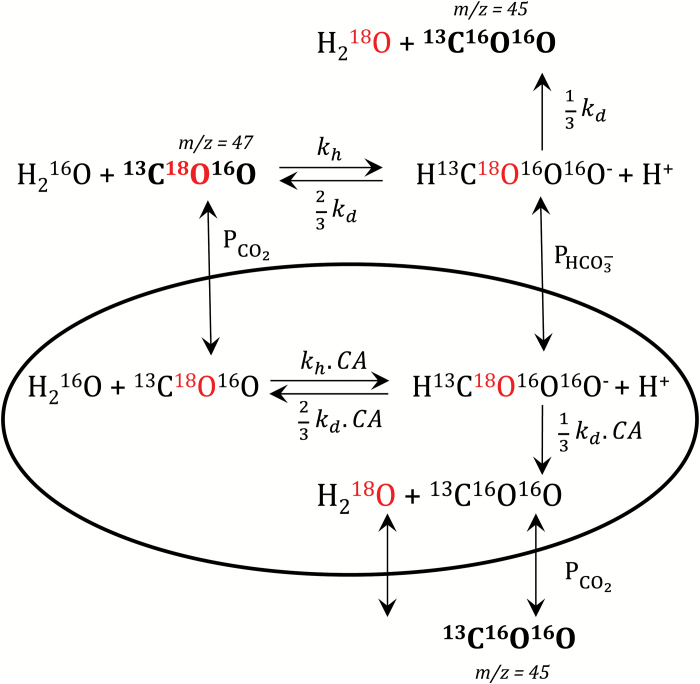
A diagram of the assumed exchange of inorganic carbon isotopes with water used in the mathematical simulations and modelling described herein. PHCO3−, HCO3− permeability of chloroplast; PCO2, CO2 permeability of chloroplast; kh, CO2 hydration rate constant; kd, HCO3− dehydration rate constant; CA, scaling factor of carbonic anhydrase activity. As the loss of 18O from Ci species is the key component of measurements, 18O is labelled in red. Ci species measurable in the mass spectrometer are in bold, and mass over charge value (m/z) specified. 13C-labelled inorganic carbon is used for all assays.